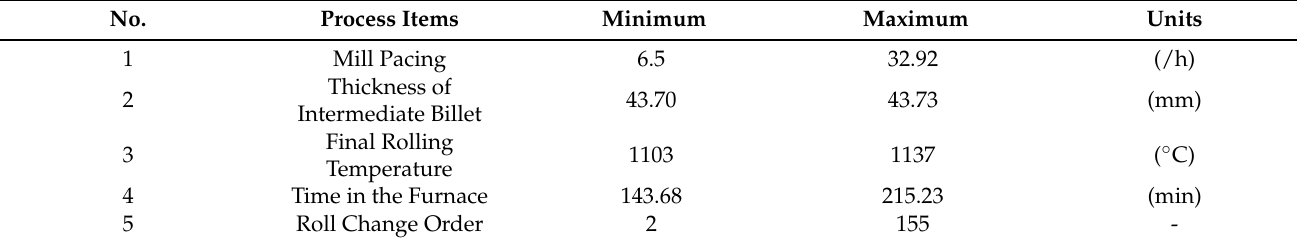
Table 5. Excellent sample set process range.